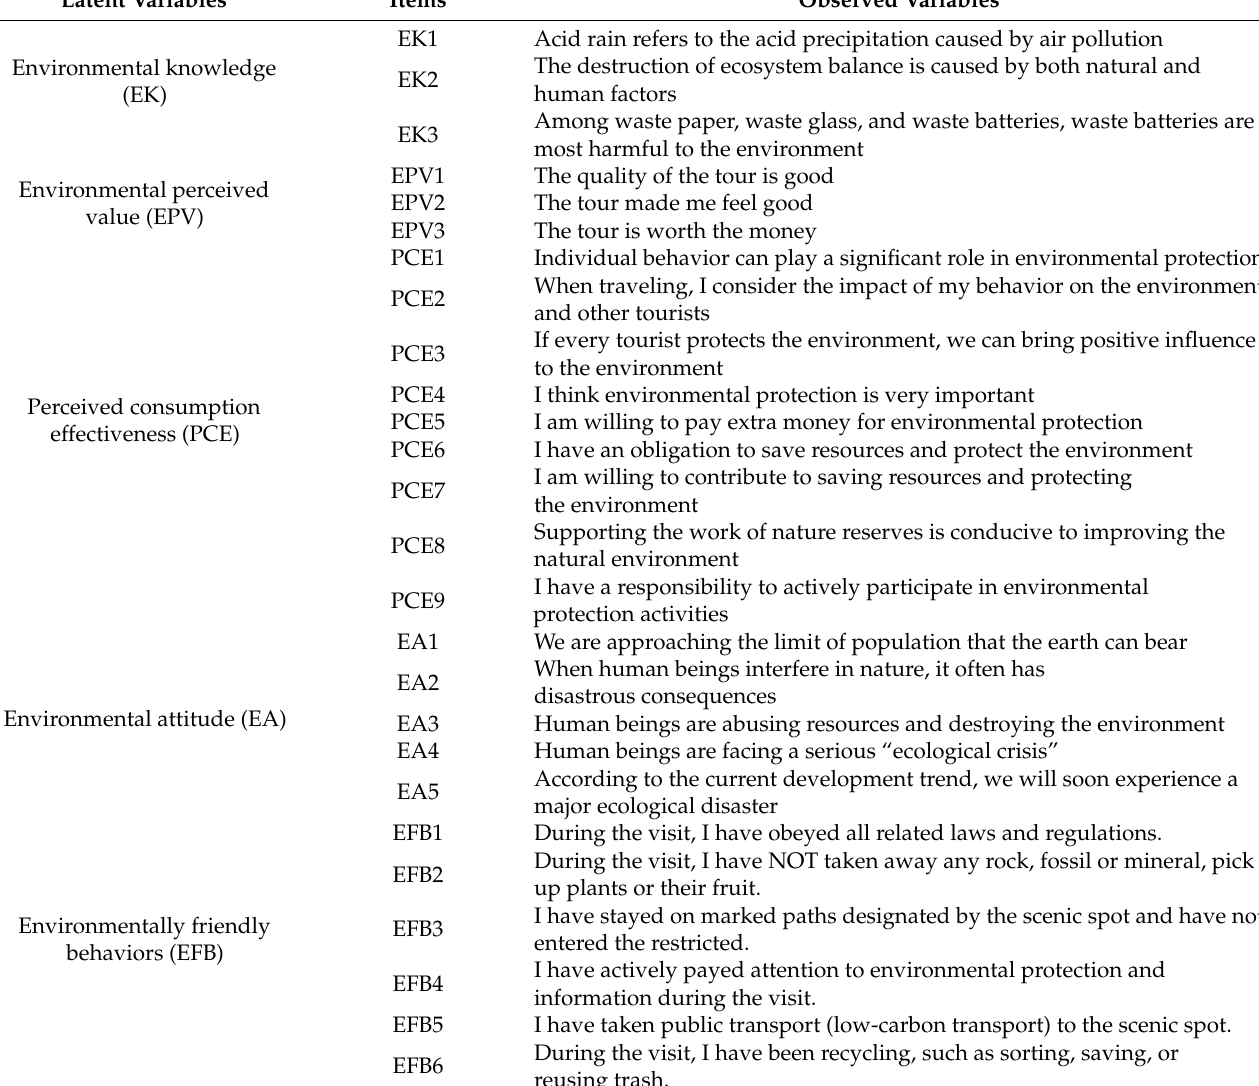
Table 1. Questionnaire items and variables